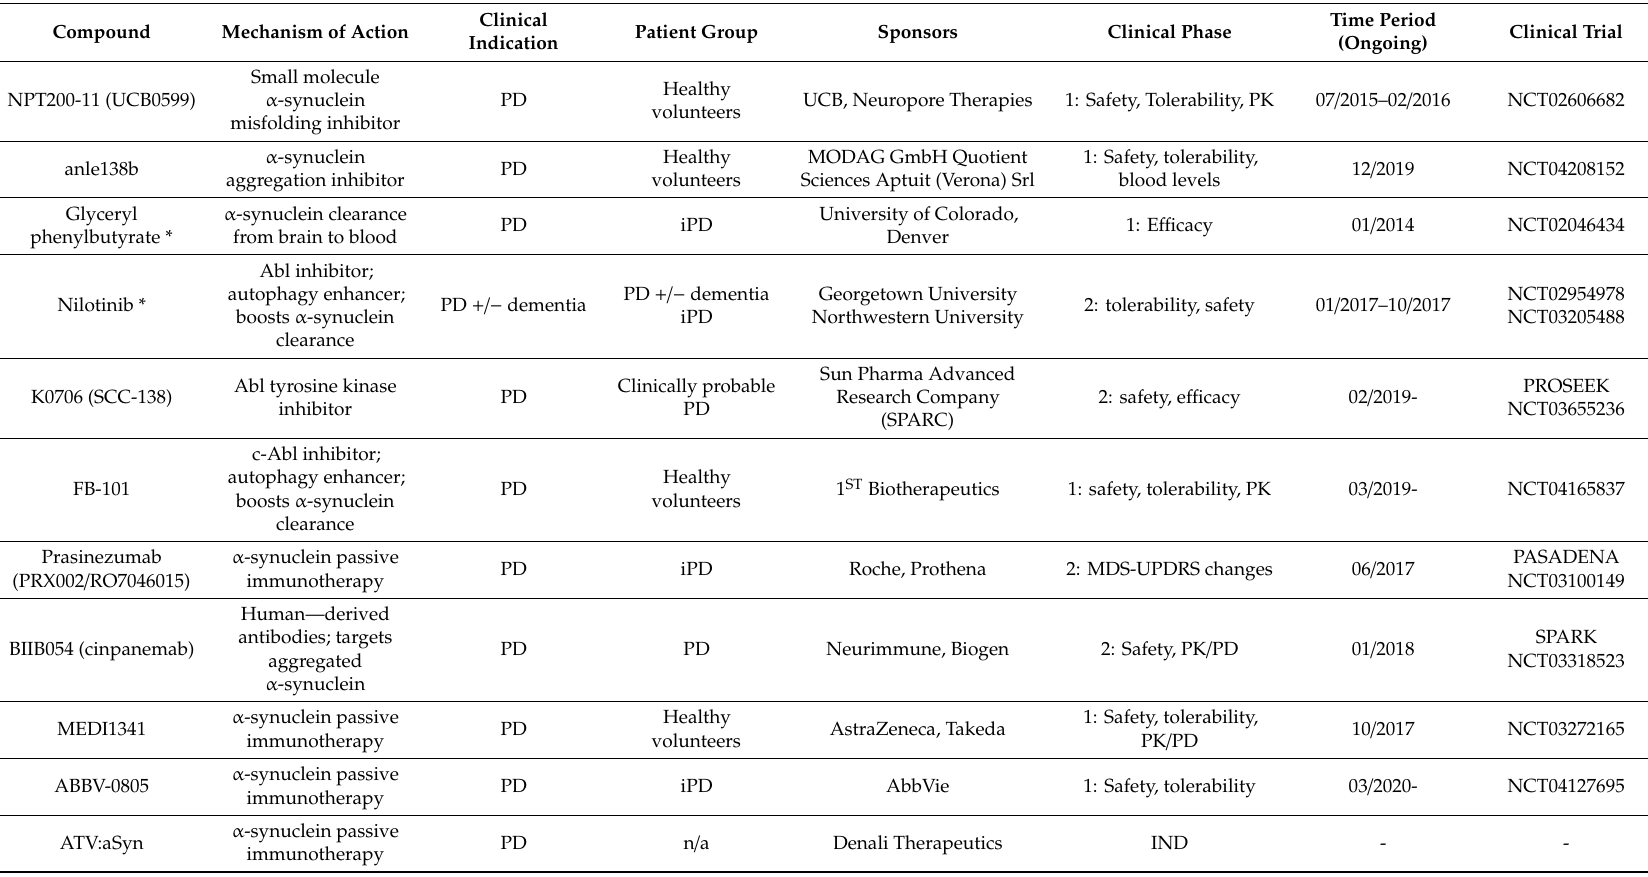
Table 1. α -synuclein